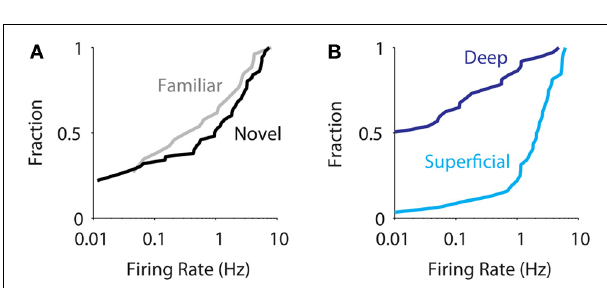
novel/familiar experiments. Bottom: as in (B) , but for a recording in the two-compartment maze (square compartment, novel; rectangular compartment, familiar). Average firing rates in novel and familiar compartments are indicated. (E) Average firing rates of all juxtacellularly recorded neurons in novel and familiar environments. Horizontal lines connect recordings from the two-compartment maze, where novel and familiar compartments where sampled within the same recording session. Red lines indicate medians.